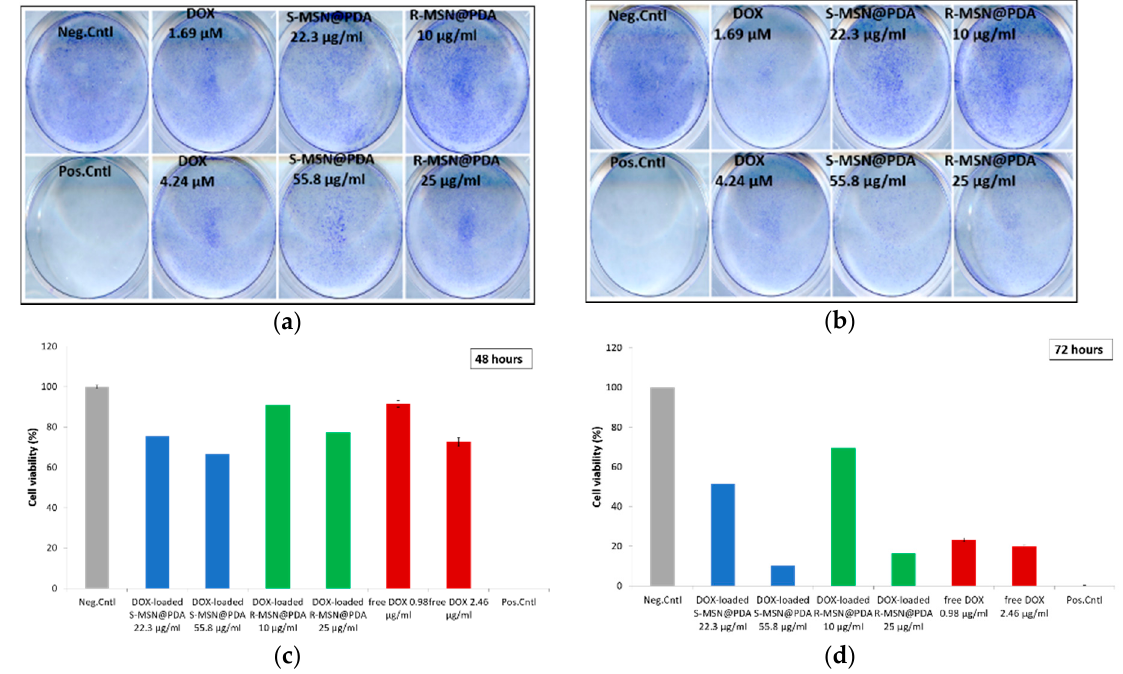
Figure 6. Cell viability of MDA-MB-231 cells as represented using crystal violet assay against the cytotoxic effect of DOX-loaded MSN@PDA particles. The top row ( a,b ) shows the scanned images of MD-MBA-231 cells treated with DOX-loaded particles and free DOX (2 repetitions). The bottom row ( c,d ) show the cytotoxicity of DOX-loaded S-MSN@PDA, R-MSN@PDA and corresponding concentrations of free DOX with MD-MBA-231 cells at 48 and 72 h of incubation as analyzed using the Colony Area plugin in ImageJ. Negative control indicates untreated cells, while positive control indicates cells treated with 0.1% Triton X-100.